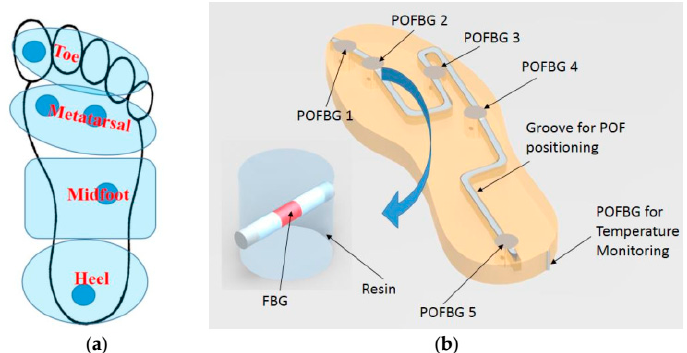
Figure 14. ( a ) Foot plantar area designation and sensing points and ( b ) FBG position in the cork insole; image from [120].